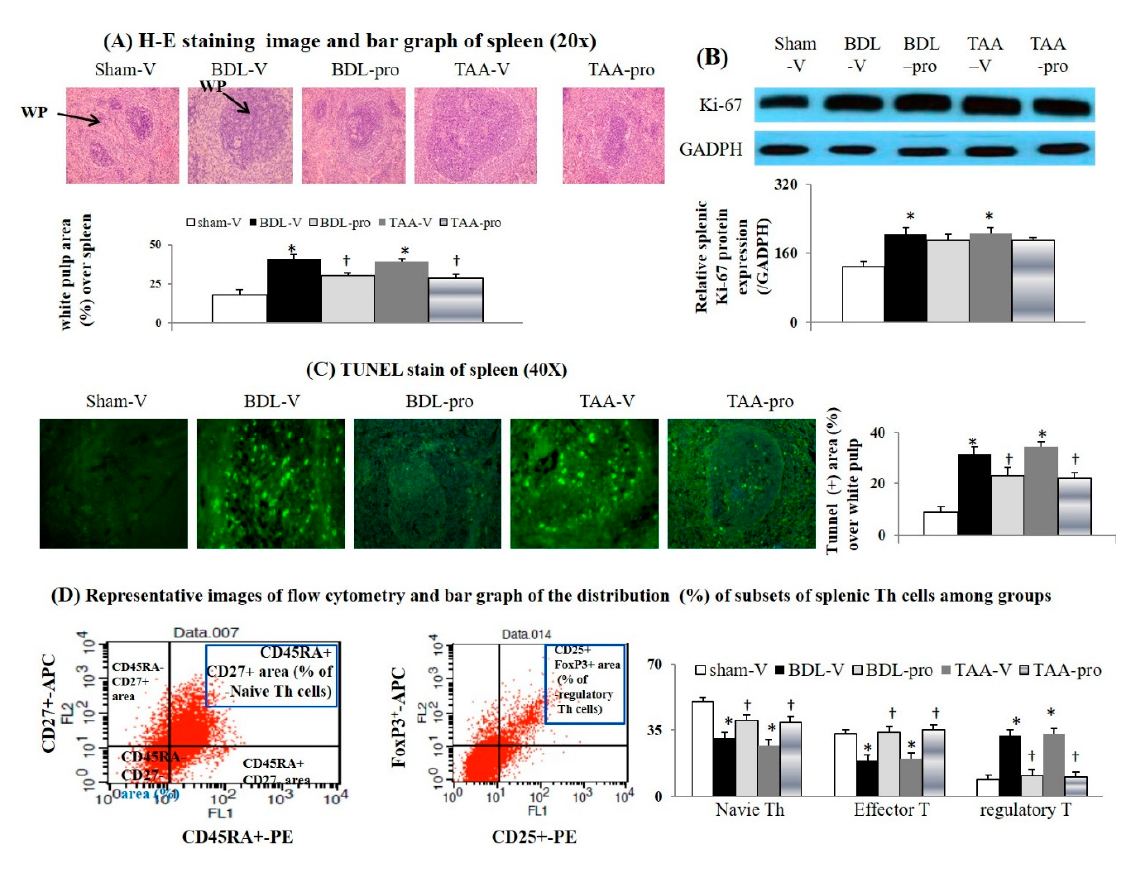
Figure 3. Chronic propranolol treatment suppressed the splenic white pulp (WP) hyperplasia, inhibited abnormal proliferative/apoptotic activities of spleen and modified distribution of the Th cell subsets in cirrhotic mice. ( A ) Representative images and bar graphs of H-E stain of splenic WP area; ( B ) Splenic Ki-67 protein expression; ( C ) Representative immunofluorescence images and bar graphs for the splenic TUNEL (+) area; ( D ) The distribution of splenic naïve T (% of CD45RA + CD27 + ) cell, effector memory T (% of CD45RA − CD27 + plus CD45RA + CD27 − plus CD45RA − CD27) cells and regulatory T (% of CD25 + FoxP3 + ) cells among CD4 + Th cells. * p < 0.05 vs. sham-V group; † p < 0.05 vs. BDL-V/TAA-V group.